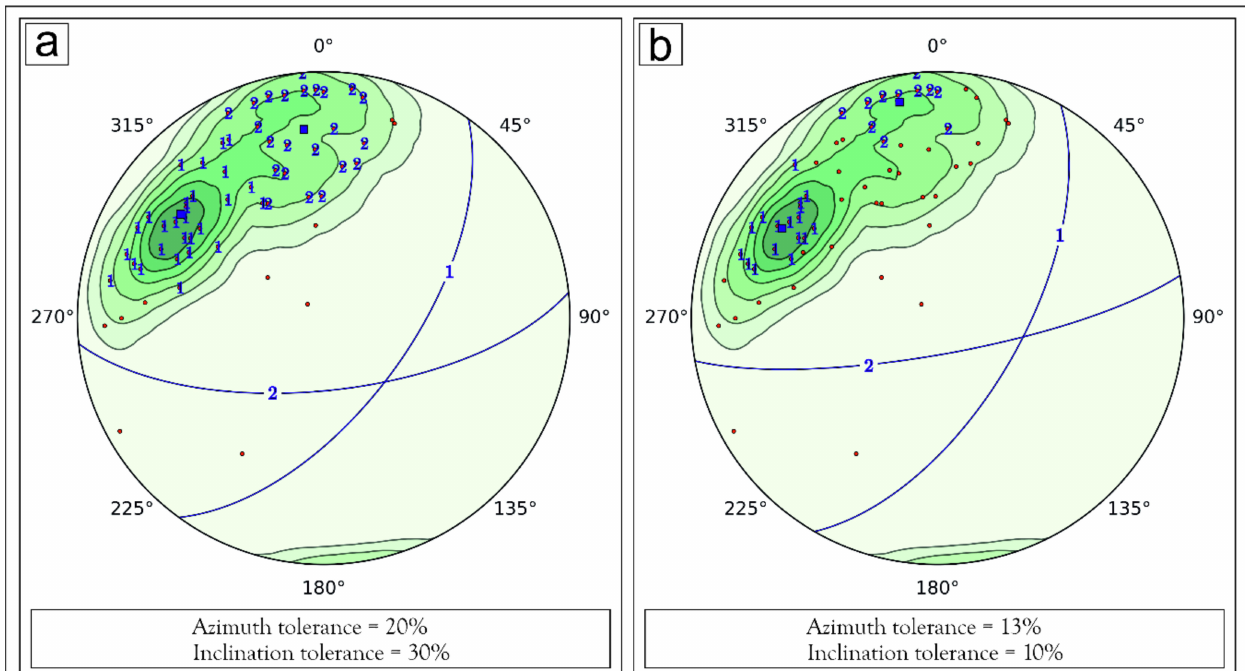
Figure 5. Influence of azimuth and inclination tolerance parameters on the M.E.A.D. clustering process, highlighted with ‘Track M.E.A.D. behaviour’ option (Figure 3d). ( a ) Two-clusters model with an azimuth tolerance of 20% and an inclination tolerance of 30%. Almost all plotted data is grouped into two different clusters (1 and 2). ( b ) Two-clusters model with an azimuth tolerance of 13% and an inclination tolerance of 10%. Extracted clusters tend to be less dispersed and, consequently, much more data is evaluated as spurious (i.e., not gathered within any